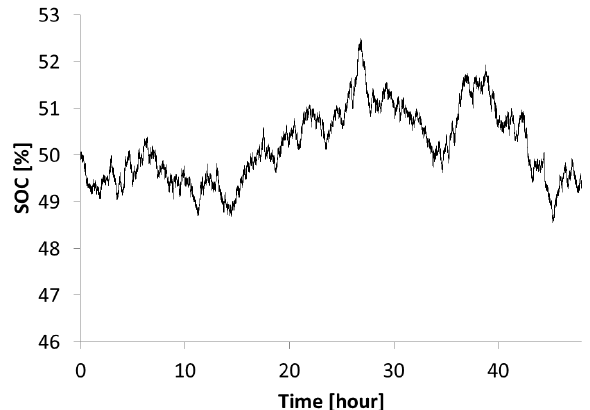
Figure 5. Simulated SOC trajectory by V2G